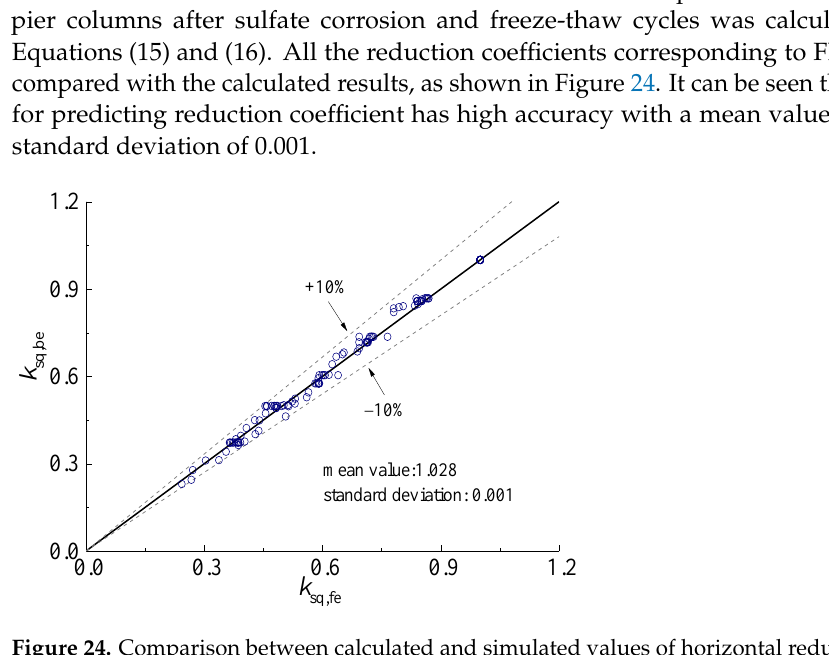
Figure 24. Comparison between calculated and simulated values of horizontal reduction coefficient.